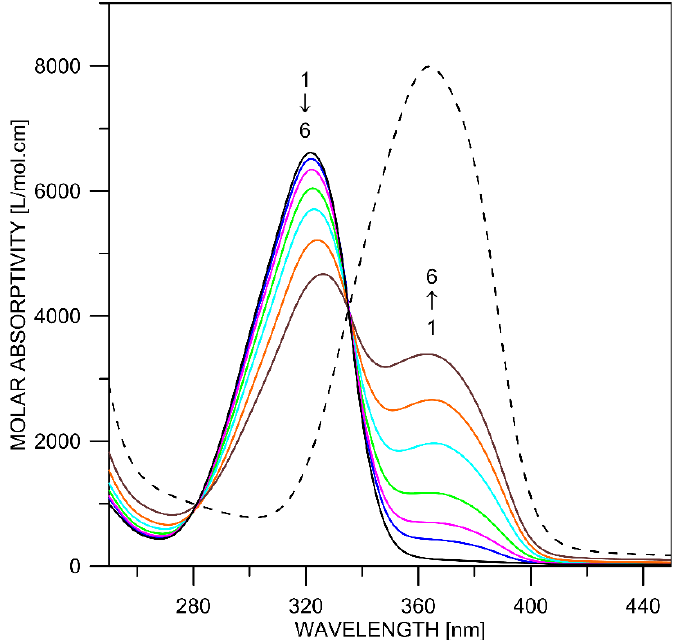
Figure 5. Absorption spectra of favipiravir ((c = 1.5 × 10 −5 M)) in acetonitrile with Mg(ClO 4 ) 2 addition with molar ratios as follows: (1) (blue line) 1:0.02, (2) (magenta line) 1:0.1, (3) (green line) 1:0.2, (4) (cyan line) 1:0.5, (5) (orange line) 1:2 and (6) (brown line) 1:3. The spectra of the pure favipiravir and the calculated spectrum of the complex are shown in black solid line and in black dashes corre- spondingly.